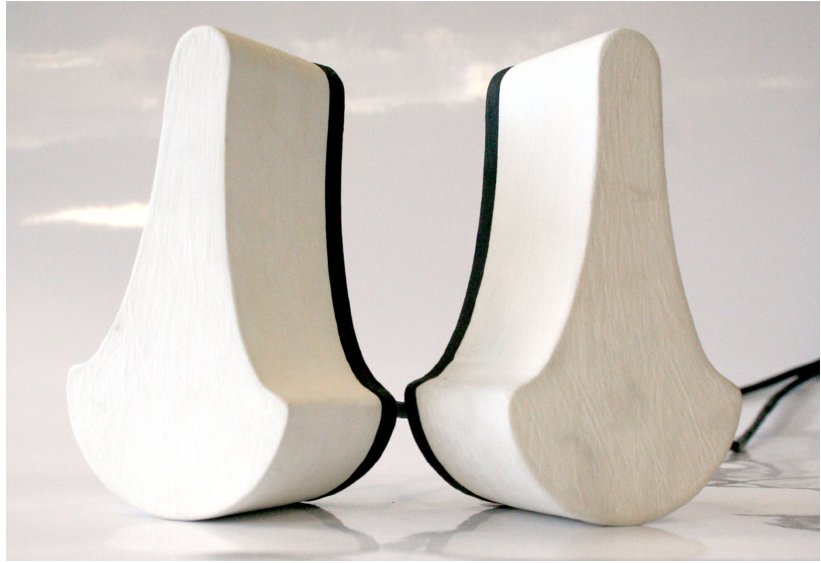
Figure 1. The collaborative artifacts that were used by the participants to browse through the photos in a cooperative